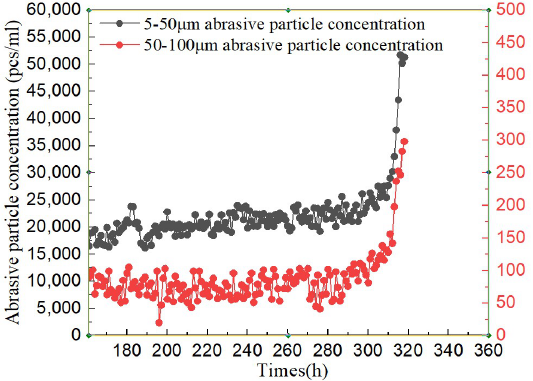
Figure 10. Amplification photograph of abnormal abrasive grains ( a ) abnormal abrasive chain, ( b ) sliding abrasive, ( c ) fatigue flake abrasives.